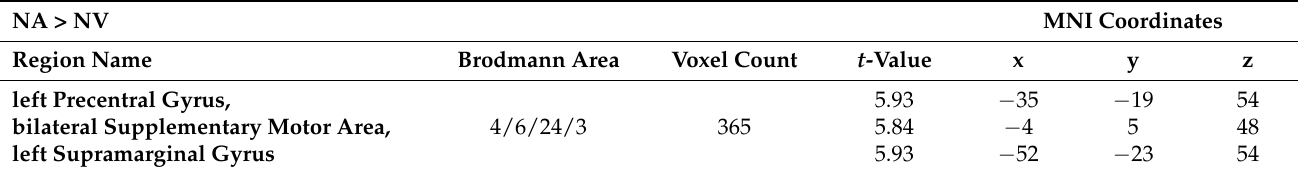
Table 3. Activation peaks and extents for NA > NV.